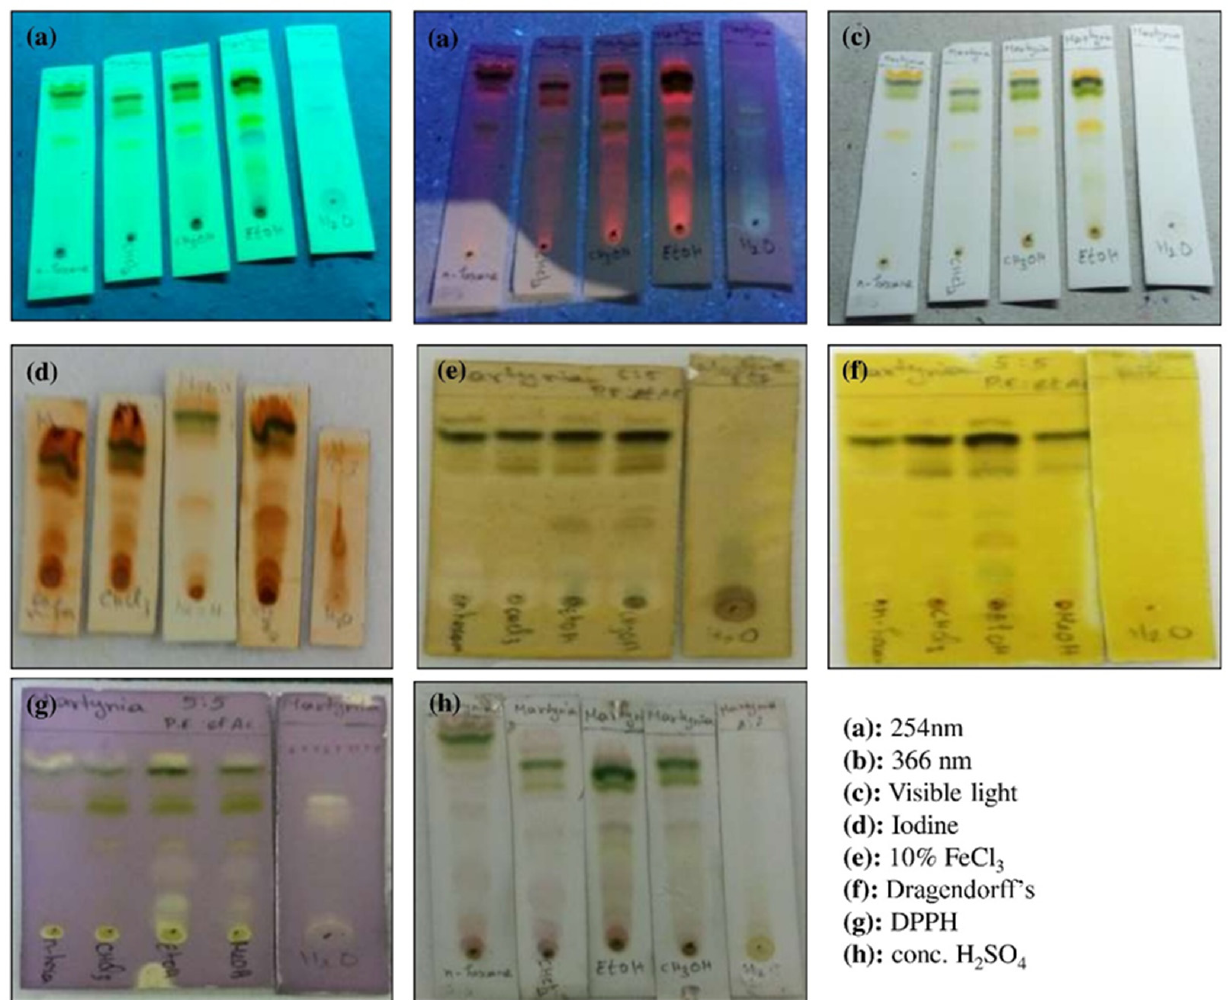
Figure 1. Different solvent extracts yield of Martynia annua Linn . mentioned values are mean and standard error of triplicates.